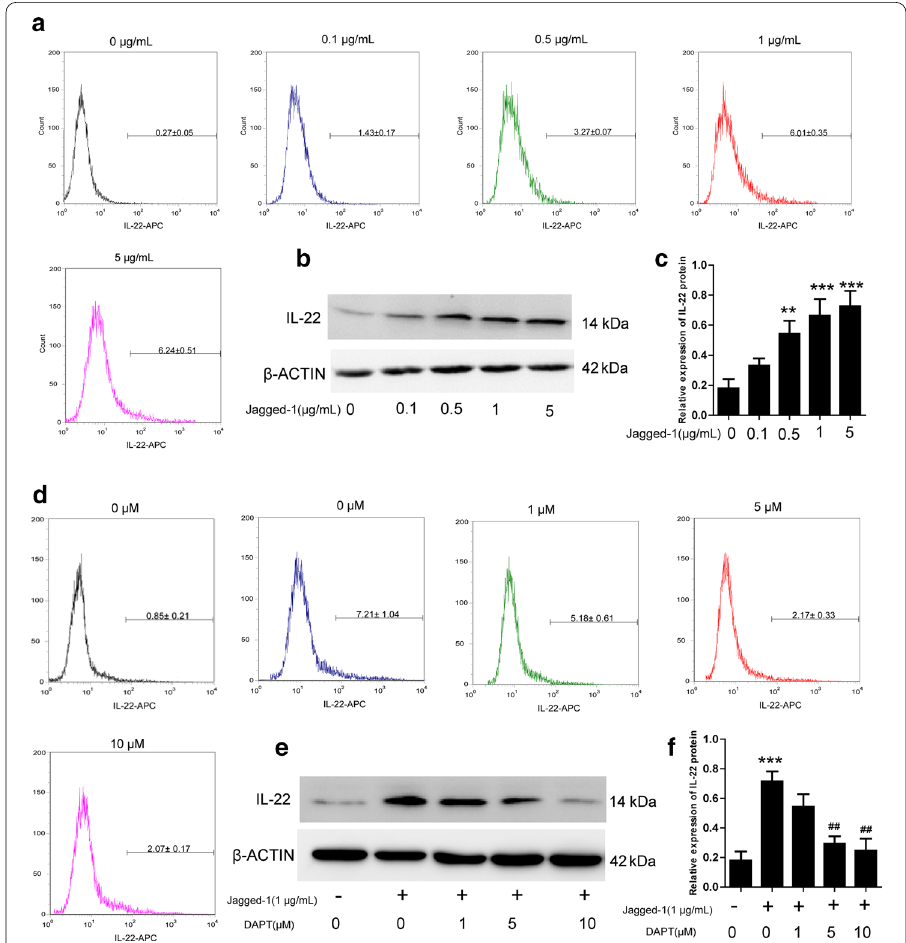
Fig. 2 Effect of different concentrations of jagged-1 and DAPT on mediated expression of IL-22. After the naïve CD4 + T cells were pretreated with a combination of factors, different concentrations of jagged-1 (0, 0.1, 0.5, 1, 5 µg/mL) were added to culture medium. a Flow cytometric analysis of the positive IL-22 cell proportion in different doses of jagged-1 treatment. b , c IL-22 proteins were determined by Western blotting. d Naïve CD4 + T cells were treated with the combination of factors, and exposure with or without jagged-1 (1 µg/mL), and different doses of DAPT added (0, 1, 5, 10, 20 µM). Then, the percentages of positive IL-22 cells were assayed by flow cytometry. e , f Following the treatment, expression of IL-22 protein was determined by Western blotting. Data are presented as the mean SD of three independent experiments. ** p < 0.01, ± *** p < 0.001 vs. untreated control, ## p < 0.01 vs. jagged-1 (1 µg/mL) without DAPT